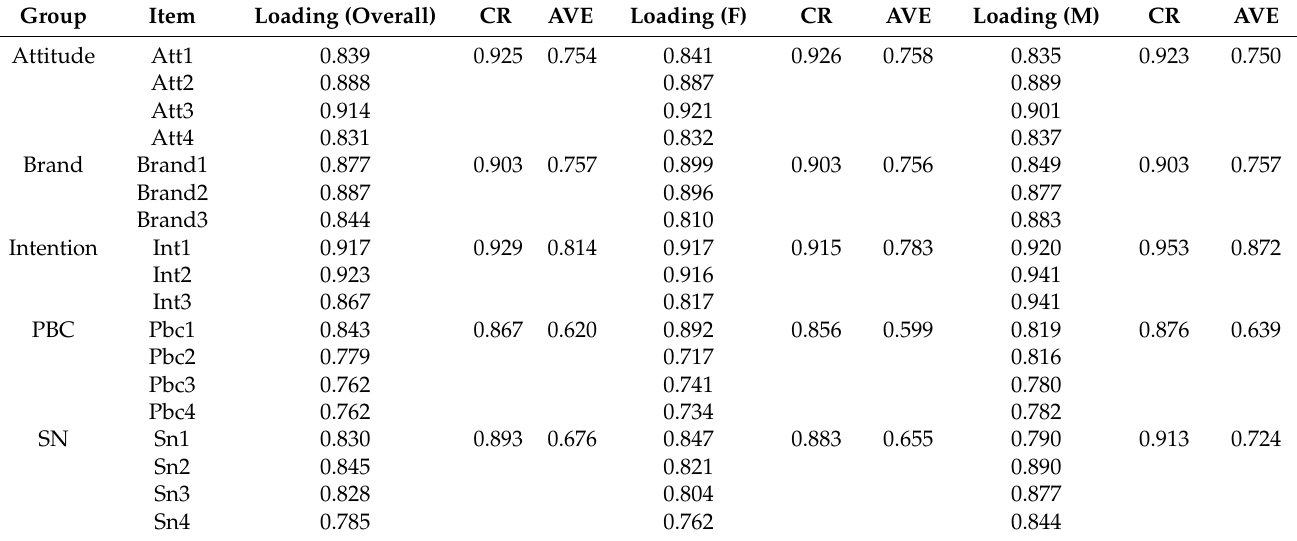
Table 2. Convergent validity.